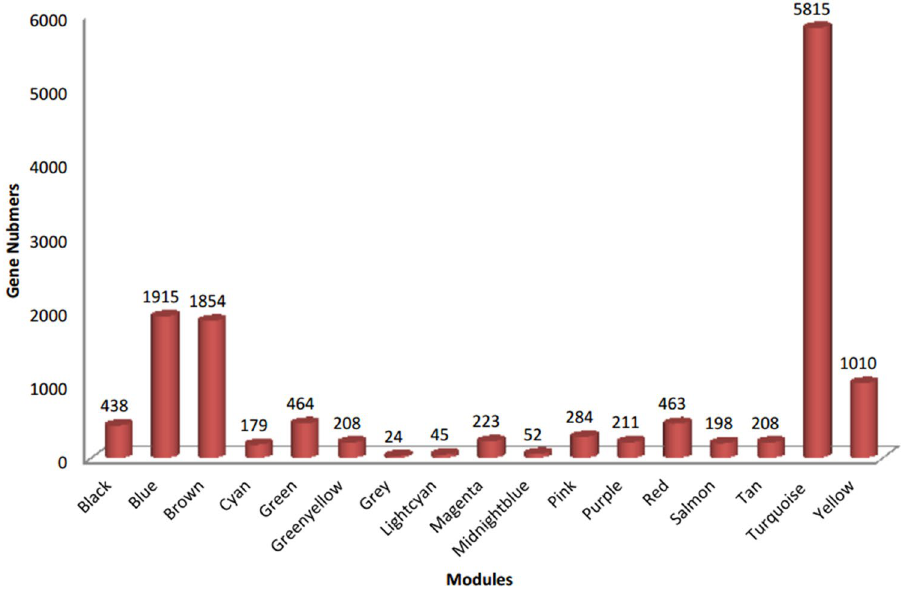
Figure 3. The 17 modules identified by the weighted co-expression analysis (WGCNA) along with the number of genes in each